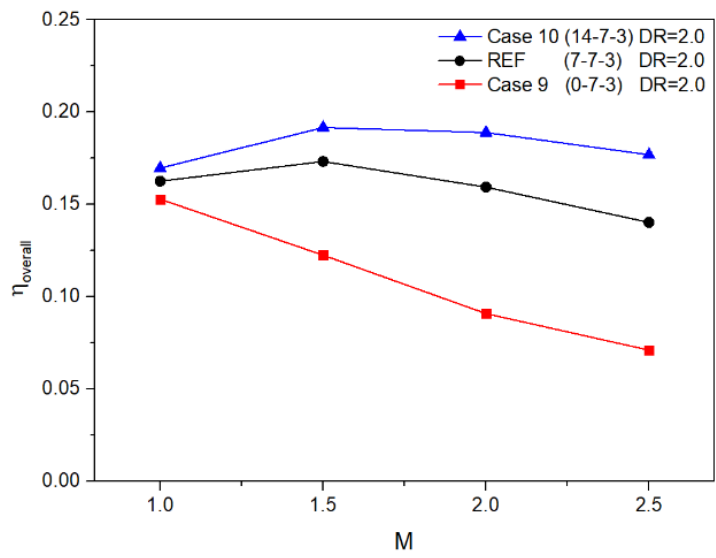
Figure 8. Overall averaged FCE for X-7-3 cases.